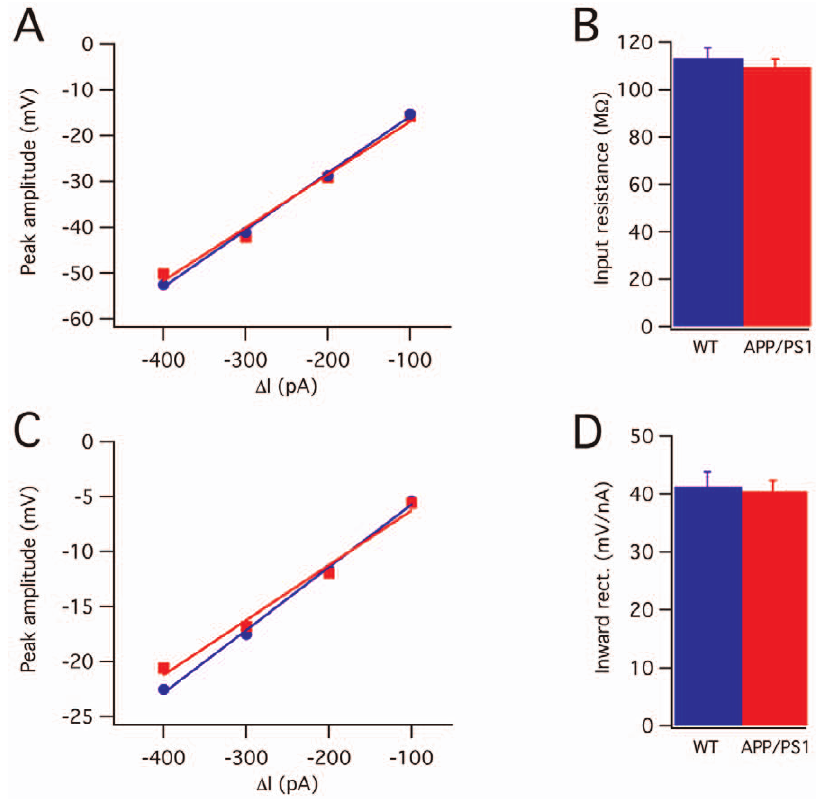
Figure 1. Responses to hyperpolarizing currents. ( A ) Example of plots of peak amplitudes versus injected currents. Each point is the average of five trials. Data were fitted by a linear function. Blue circles and lines: wild-type; red squares and lines: APP/PS1 ( B ) Mean input resistance values of wild-type (blue column, n=14) and APP/PS1 (red column, n=20) PCs. There is no significant difference (P . 0.05). ( C ) Example of plots of inward rectification (IR) versus injected currents. Each point is the average of five trials. The line is the linear fitting. ( D ) Mean inward rectification of wild-type and APP/PS1 PCs.